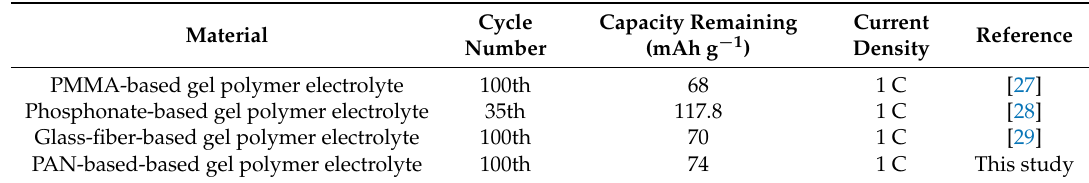
Table 1. Literature data comparison on the electrochemical performances of gel polymer electrolytes for sodium-ion